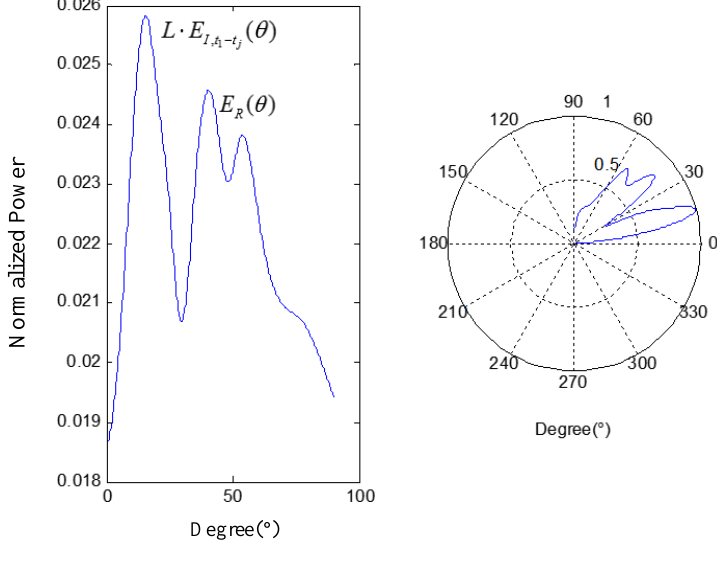
Figure 4. Angle-power relation.